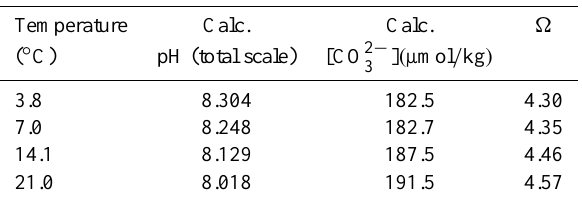
Table 2. Water chemistry measured during the course of the ex- periment together with calculated values of pH(total scale), CO 2 − and (cid:127) . The average measured salinity, alkalinity, and DIC of the 200L reservoir (35.35 (SD 0.26); 2264.0µeq/kg (SD 6.6), and 2001.0µmol/kg (SD 6.8)) were used for calculations at all four tem- peratures, the standard deviations are presented within parenthesis, shorten to SD.